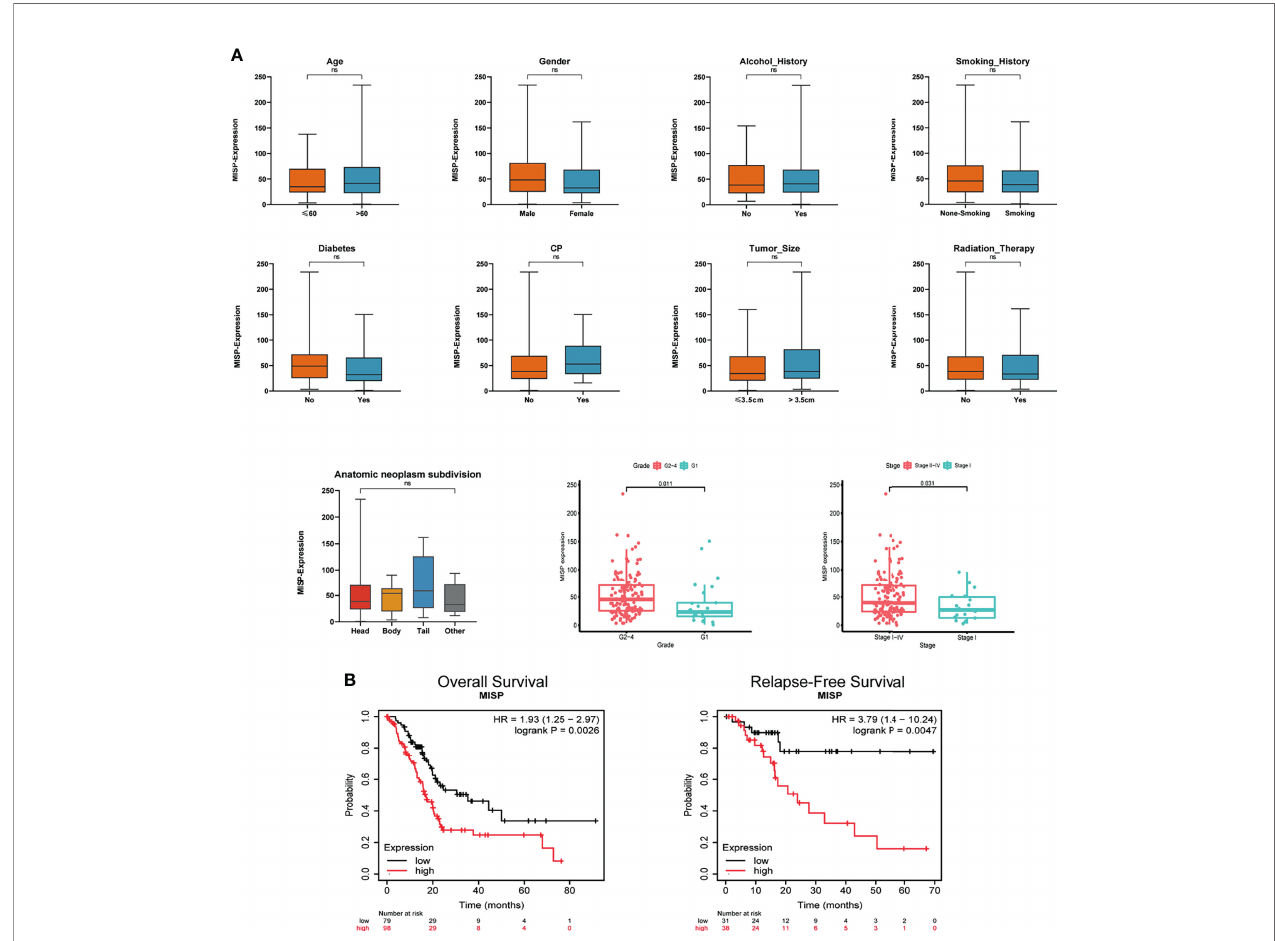
FIGURE 2 | Clinical correlation and prognosis analysis based on TCGA and Kaplan-Meier Plotter database. (A) Clinical correlation based on TCGA (B) OS and RFS analysis in the Kaplan-Meier Plotter database based on TCGA data. ns, not signi fi